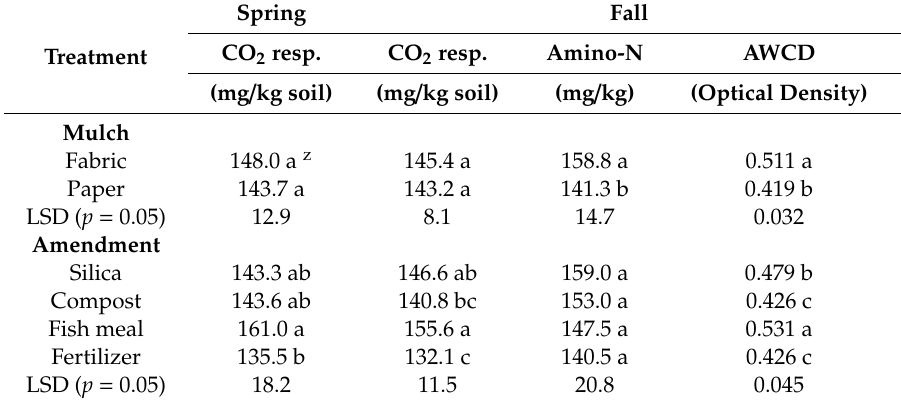
Table 4. Soil microbiological properties in the spring and fall of 2018 as a ff ected by mulch type and soil amendment, and as measured by CO 2 respiration and soil Amino-N (Solvita CO 2 burst test and SLAN test) and microbial activity based on average well color development (AWCD) in substrate utilization (BIOLOG)